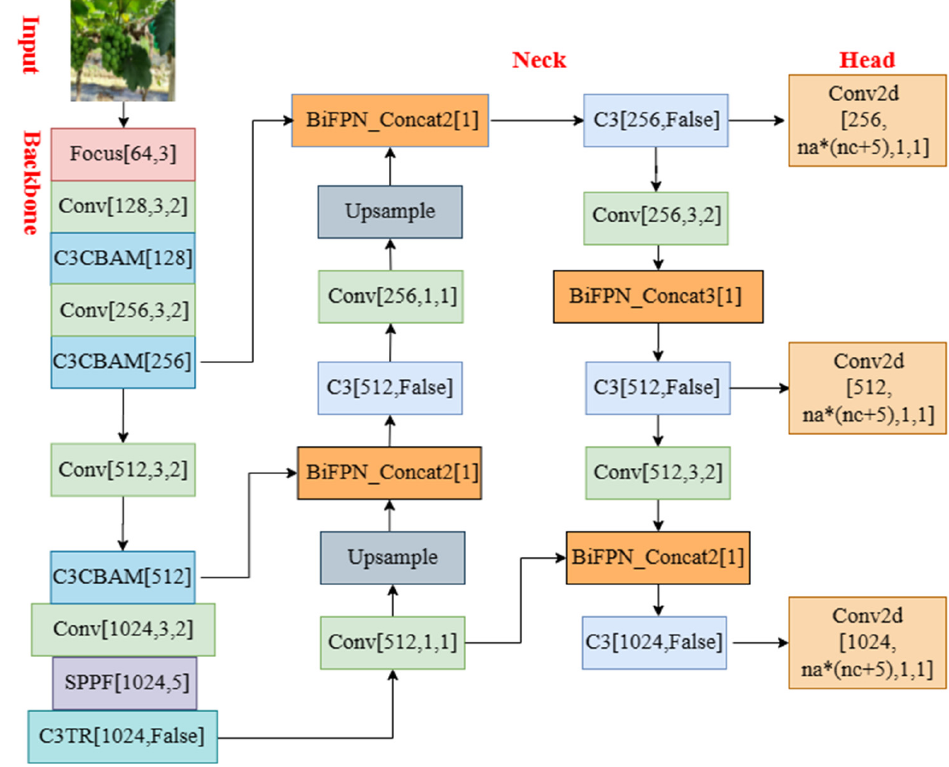
Figure 3. YOLOv5-GAP network structure diagram.